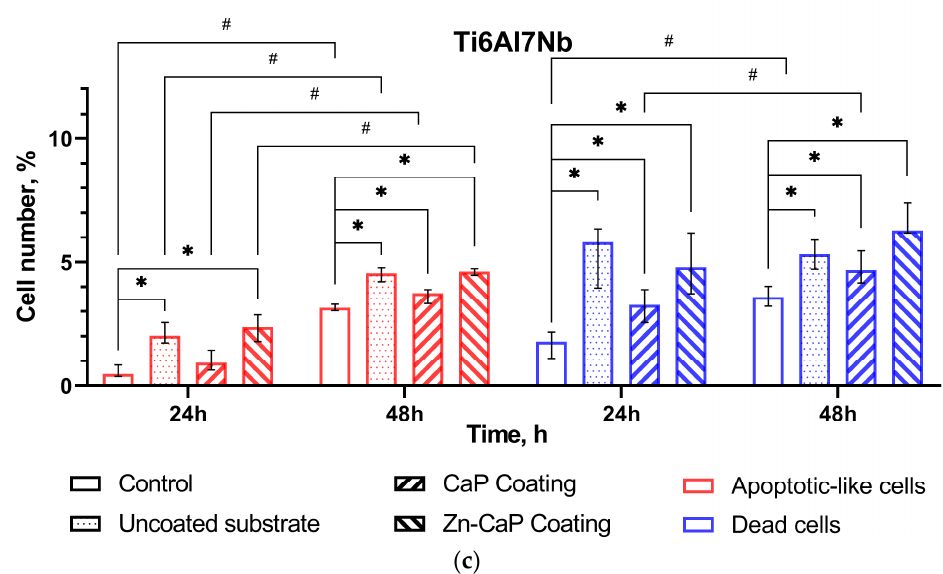
Figure 8. Calculation of live ( a ), apoptotic-like, and dead ( b , c ) Jurkat T cells after 24–48 h culture without (control) or with different one-sided CaP coatings deposited by RFMS on metal substrates, Me (Q1–Q3). Statistical differences ( p < 0.05) are shown: * with control culture without test samples; # with corresponding values for 24 h culture according to Mann–Whitney test. Other differences are presented in Supplementary Table S1.